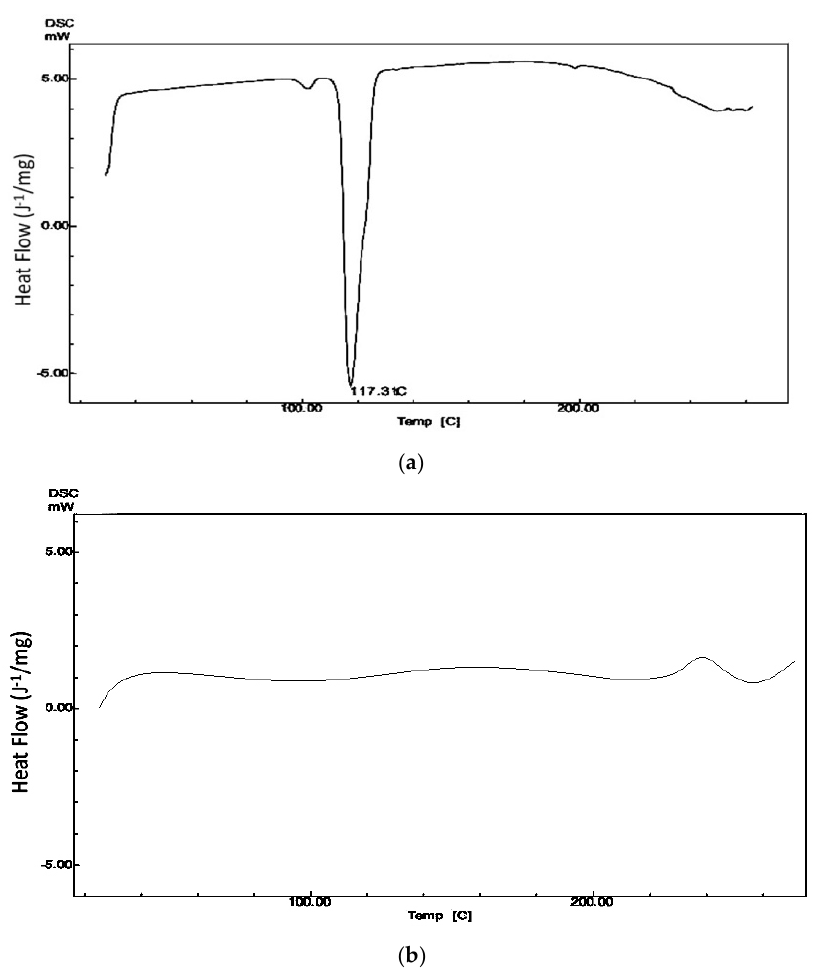
Figure 7. DSC thermograph of pure drug ( a ) and of liquisolid compacts ( b ).